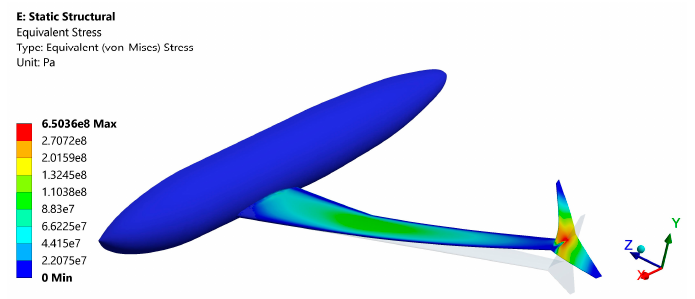
Figure 21. An example of 34% growth of maximum DLR-F4 wing spanwise stress due to the installation of a winglet with a large cant angle ψ = 75 ◦ . High subsonic air flow regime: M = 0.8, α =1 ◦ .